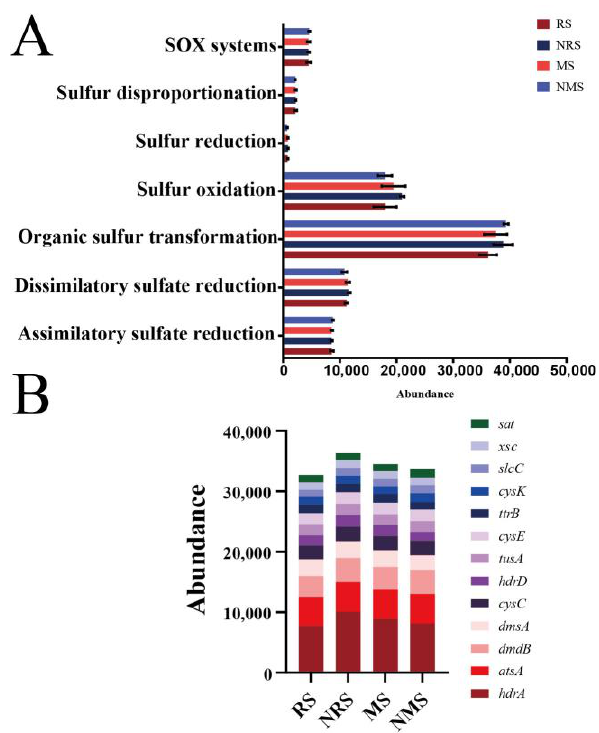
Figure 2. ( A ) Pathway abundance values in the samples. ( B ) Bar chart indicating the relative abundances values of 12 abundant sulfur gene (sub)families in each sample.